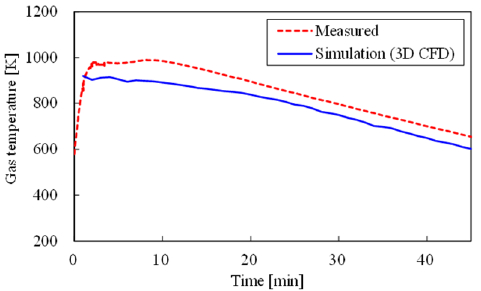
Figure 17. Gas temperature profiles obtained by pilot test and CFD simulation.